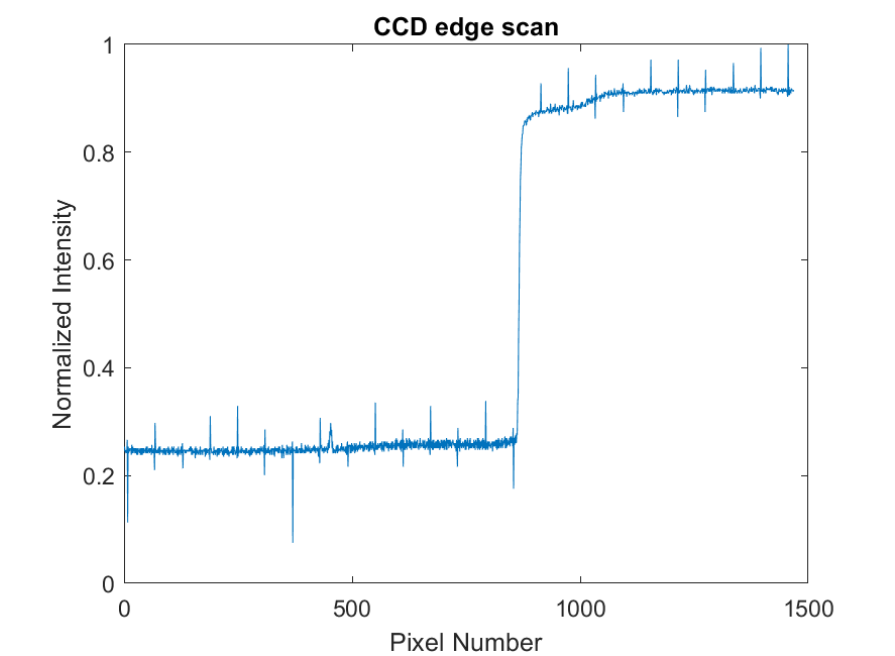
Figure 18. Output of the CCD sensor. It shows the edge of the wafer. The edge is a curve over 10